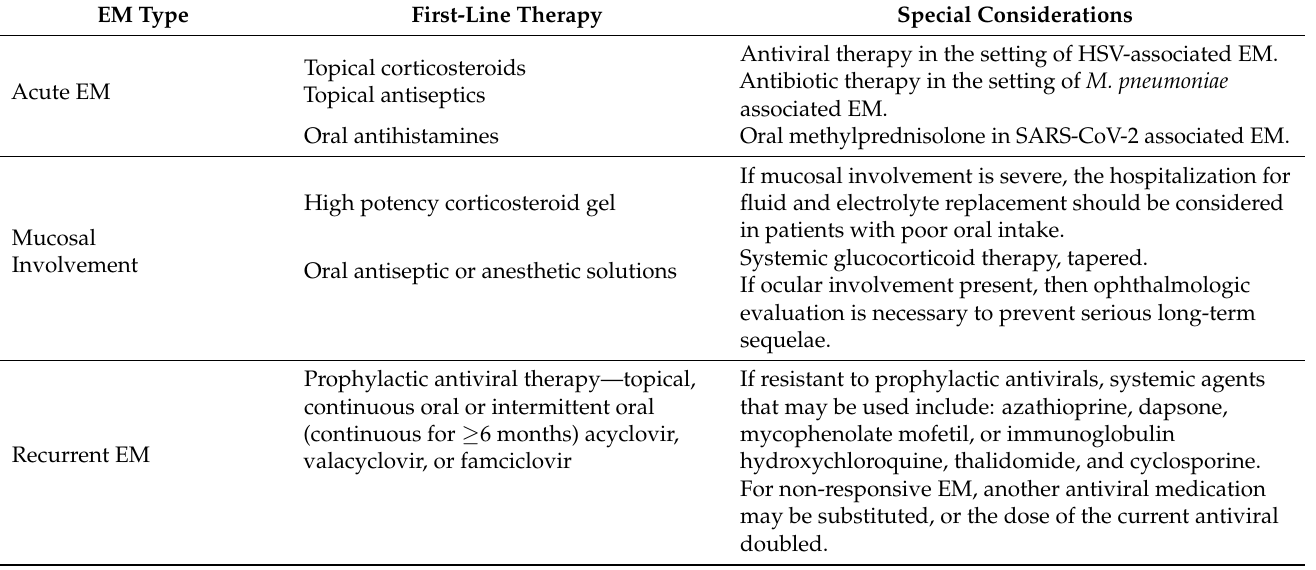
Table 2. A summary of the first-line treatment for each type of EM as well as special considerations that need to be evaluated in each case. Adapted from “Clinical Features, Diagnosis, and Treatment of Erythema Multiforme: A Review for the Practicing Dermatologist” by Sokumbi et al. [1] with permission from the John Wiley and Sons Publishing on behalf of the International Journal of Dermatology, ©